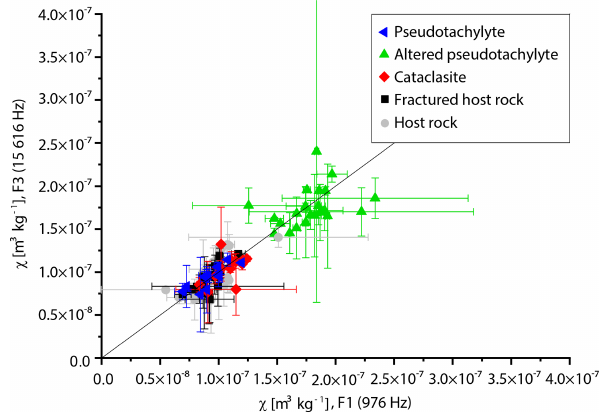
Figure 9. Mass-dependent susceptibility ( χ ) measured as a func- tion of frequency. Error bars represent 1 σ standard deviation from repeat measurements of bulk magnetic susceptibility (8 ≥ n ≥ 3). Note that the presentation format of data for the different rock types differs compared to Figs. 7 and 8, which present the mean magnetic susceptibility ( k 1 + k 2 + k 3 /